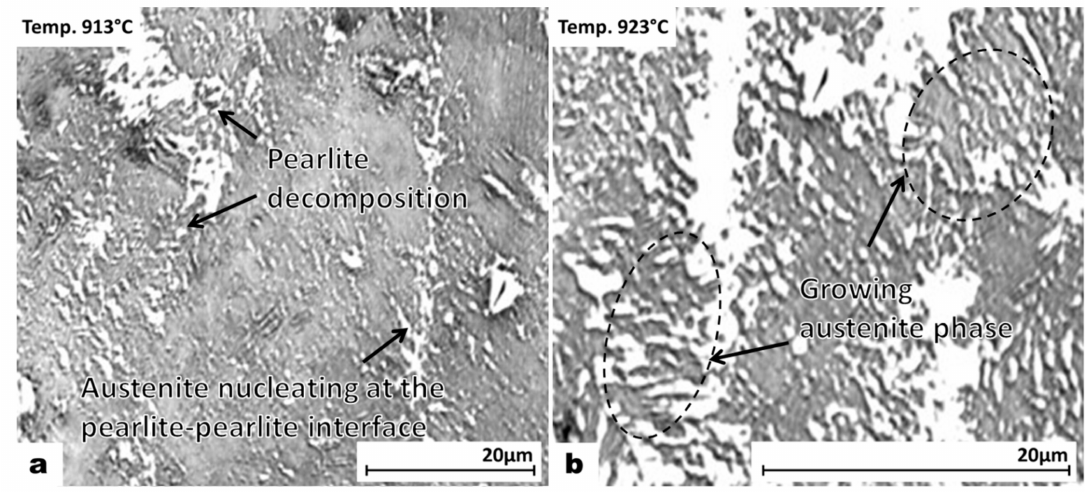
Figure 4. CSLM micrographs of nucleation sites and growth behavior of austenite. ( a ) Nucleation of austenite inside the pearlite colonies and at the pearlite-pearlite interface. ( b ) Growing mechanism of austenite by transforming